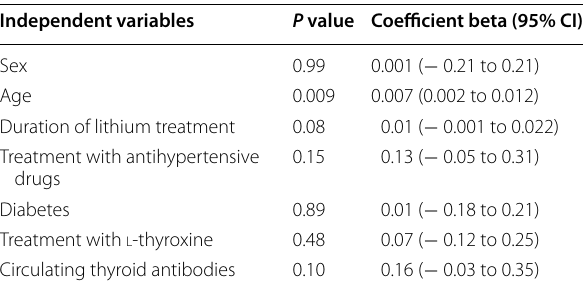
Table 3 Regression analysis using three different eGFR categories (G1/G2; G3a; G3b) as the dependent variable Independent variables